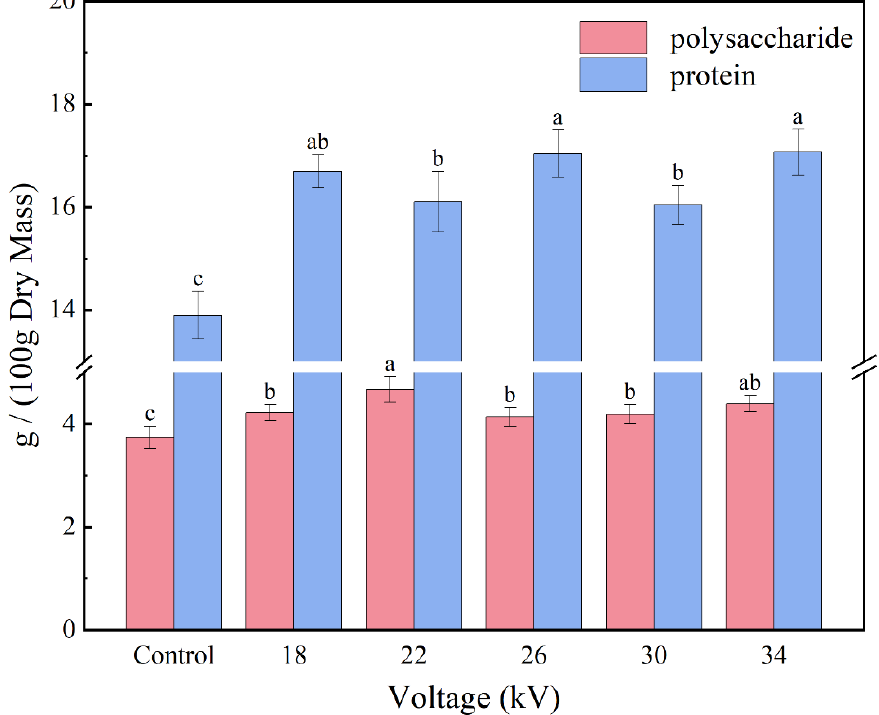
Figure 10. Contents of polysaccharide and protein in shiitake mushroom slices. Different letters indicate significant differences ( p < 0.05) between sample means.